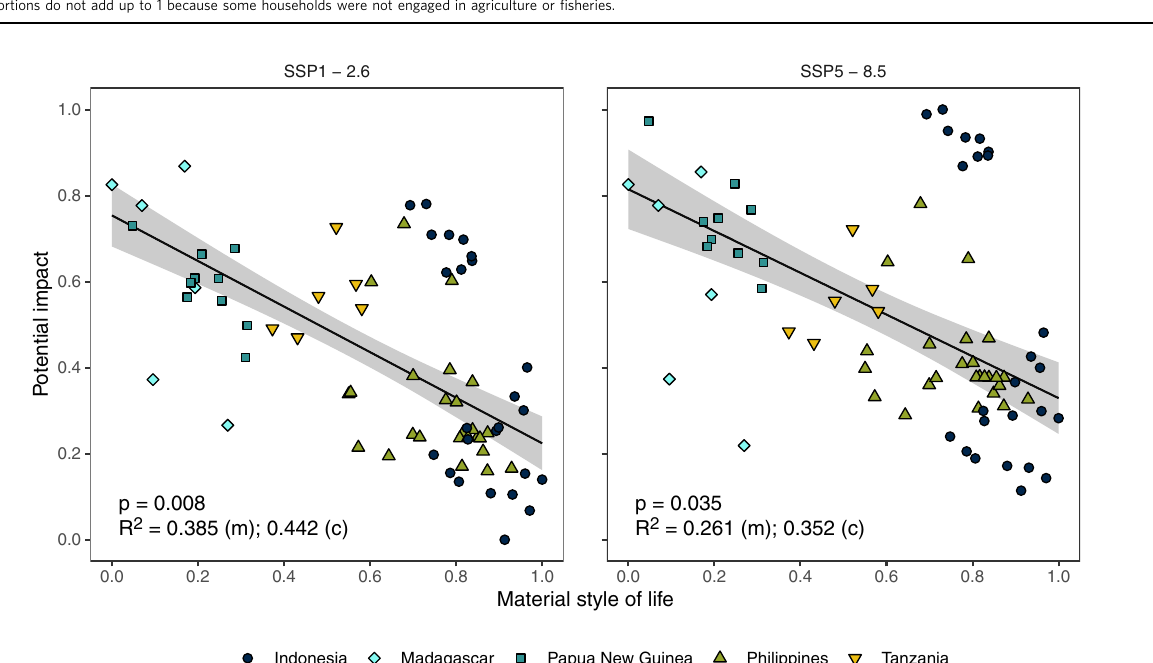
Fig. 4 Relationships between potential impacts (calculated as the Euclidean distance of exposure and sensitivity) and material style of life (a metric of wealth based on material assets) under different mitigation strategies across all studied communities ( n = 72). Black lines are predictions from linear mixed-effects models (with country as random effect) and grey bands are standard errors. Statistical signi fi cance ( p ) and fi t ( R 2 ) of the mixed-effects models are also shown: (m) = marginal R 2 , (c) = conditional R 2 . Point shape and colour indicate